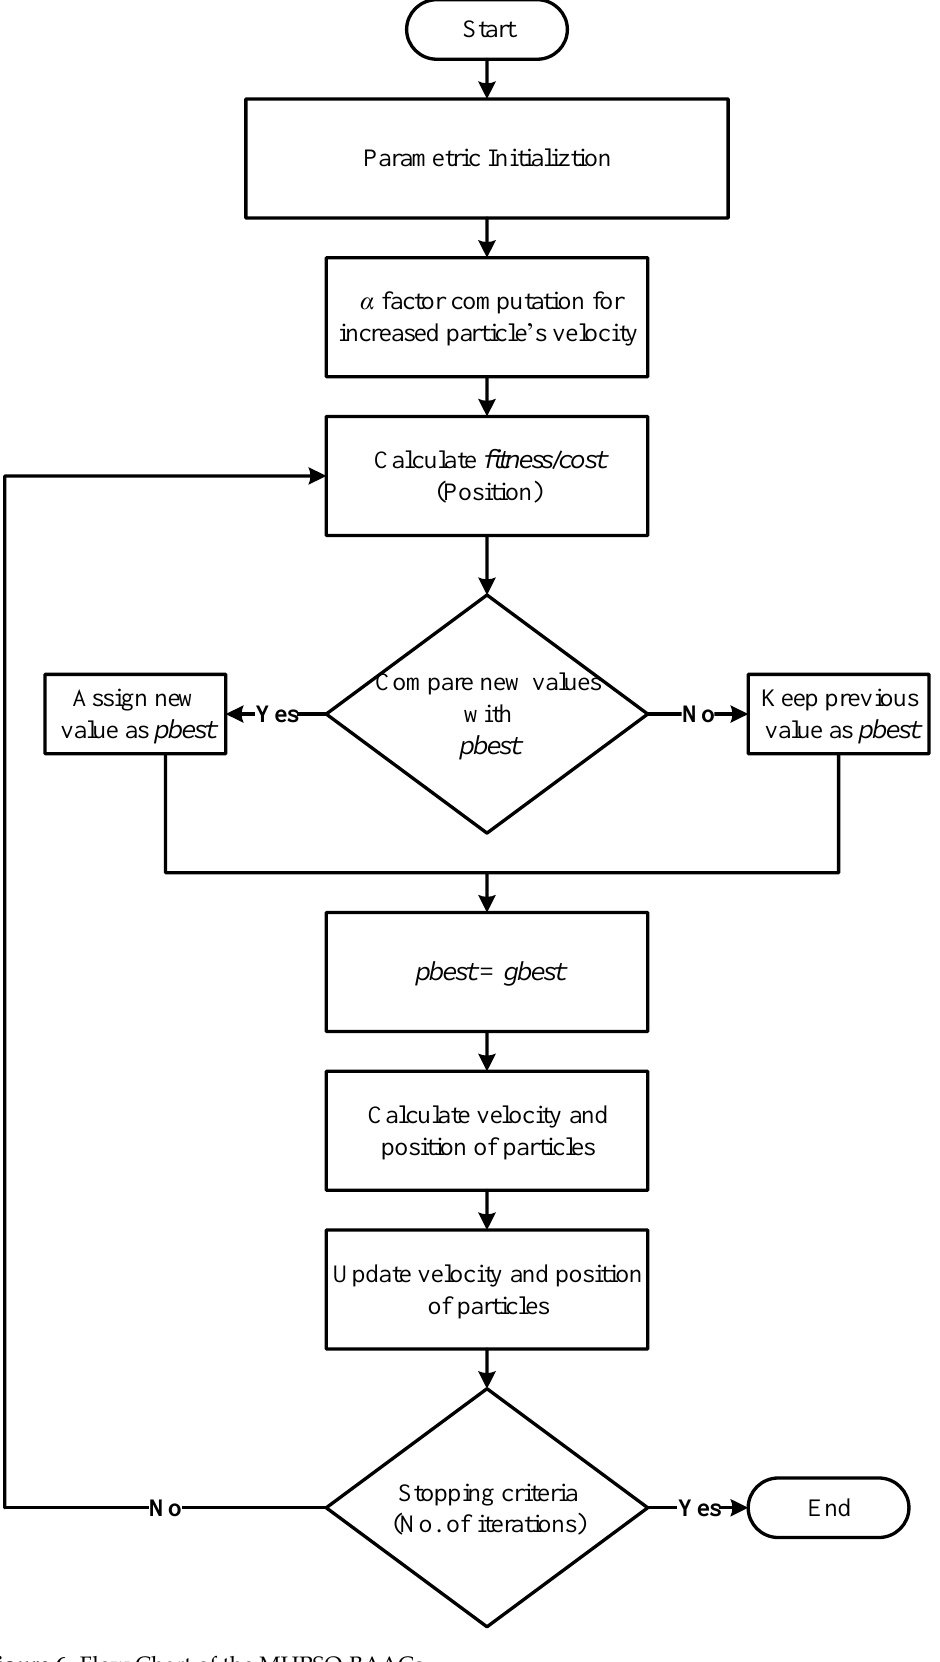
Figure 6. Flow Chart of the MHPSO-BAACs.